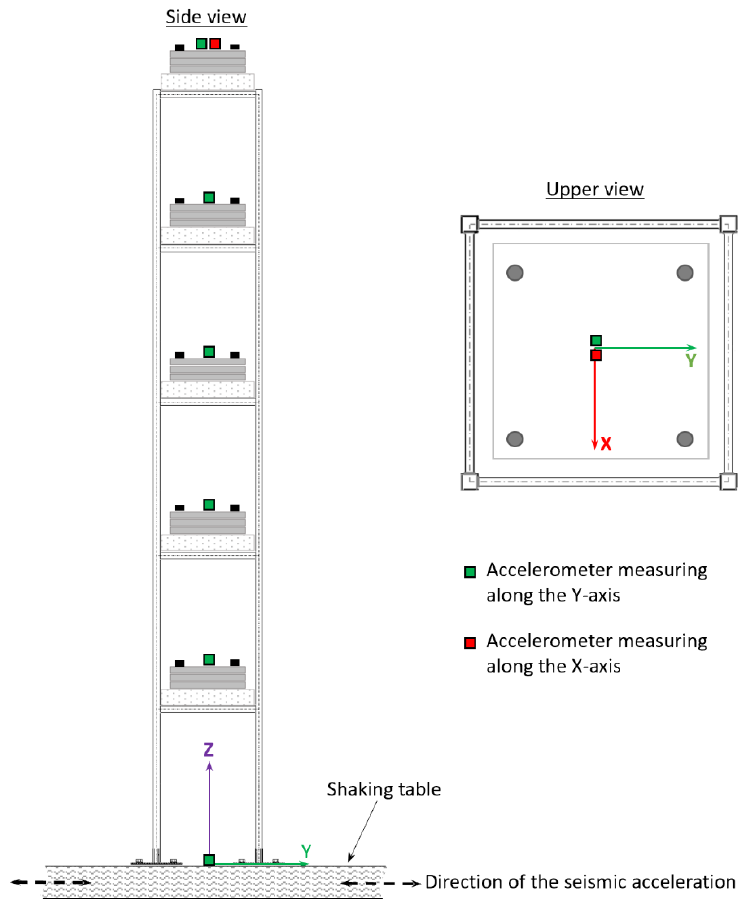
Figure 41. Accelerometers ’ location and type.